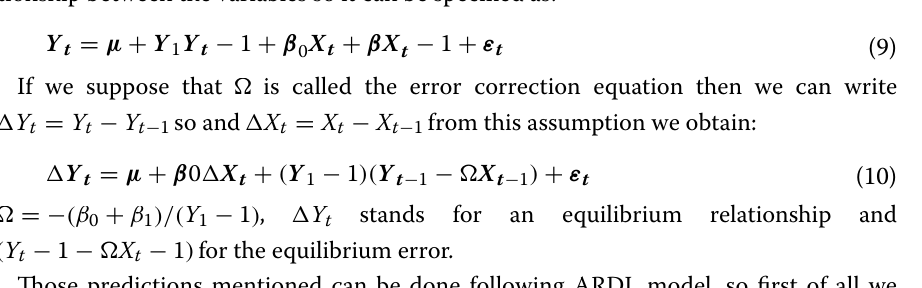
The regressions at level and in first difference include trend and intercept ***Indicates rejection of null hypothesis of non-stationary of the variables at 1% level of significance